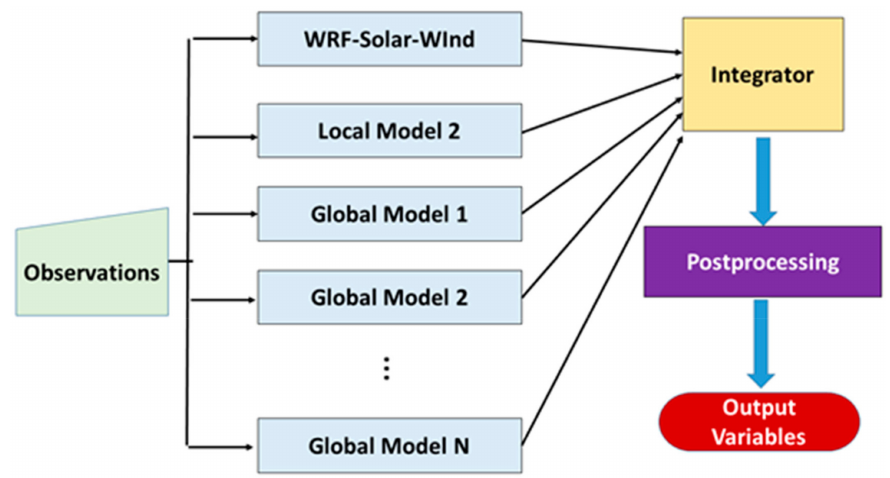
Figure 4. A schematic view of DICast ® .